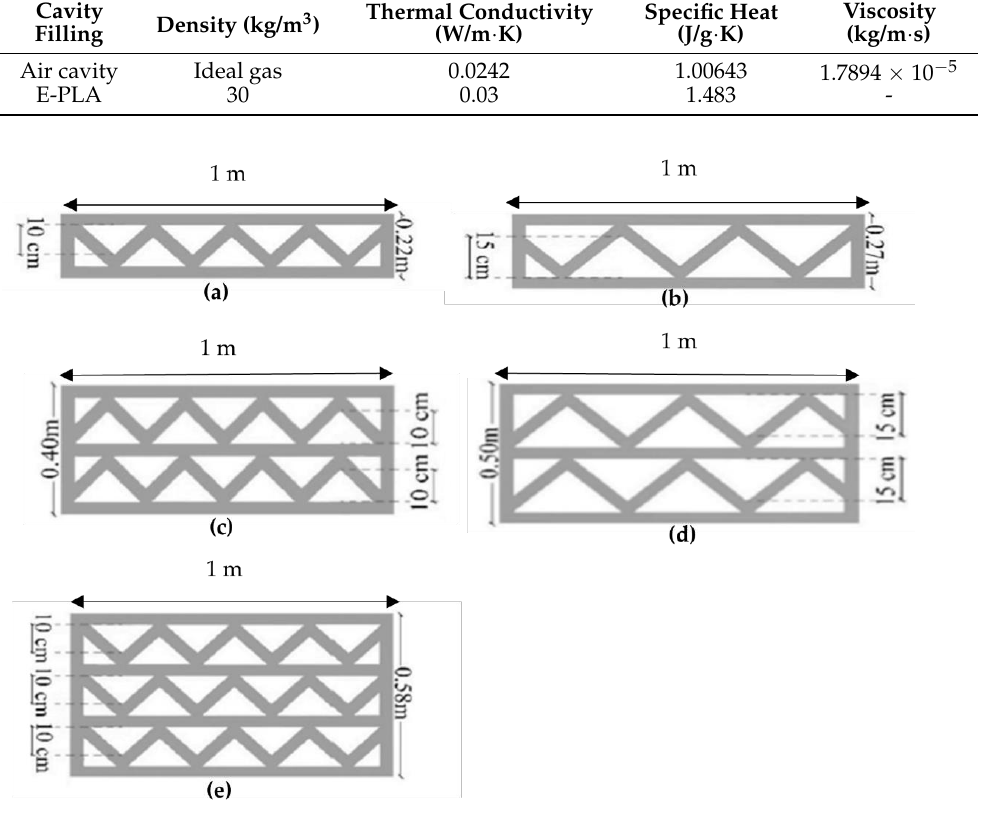
Figure 4. Wall configurations proposed by Alkhalidi and Hatuqay [31]: ( a ) single row, 10 cm (W1); ( b ) single row, 15 cm (W2); ( c ) double row, 10 cm (W3); ( d ) double row, 15 cm (W4); ( e ) triple row, 10 cm (W5).